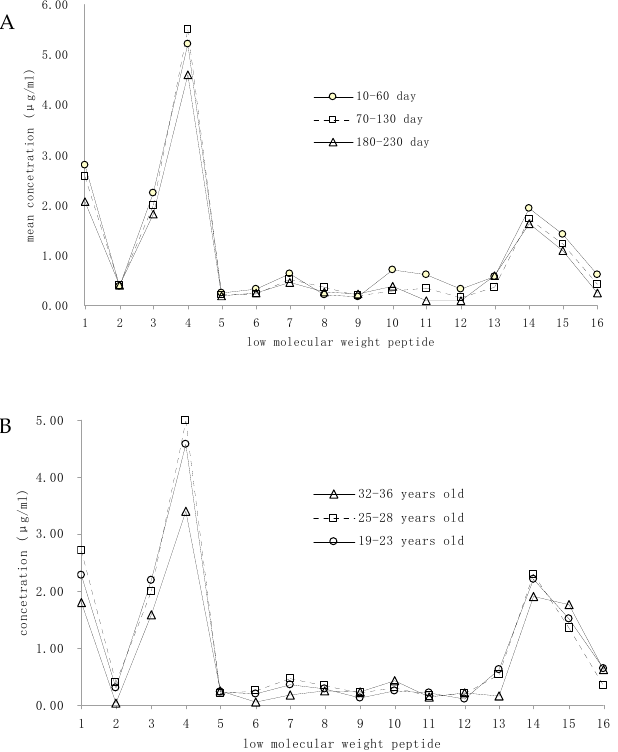
Figure 3. ( A ) The variation of main LMWPs with different lactation times. ( B ) The variation of main LMWPs with different childbearing ages. 1: RETIESLSSSEESITEYK; 2: RE- TIESLSSSEESITEYKQKVEK; 3: RETIESLSSSEESITEYKQKVEKVK; 4: ETIESLSSSEESITEYK; 5: ETIESLSSSEESITEYKQKVEK; 6: SITEYK; 7: TEYK; 8: QPAVVLPVPQPEIMEVPKAKDTVYTKG; 9: VVLPVPQPEIMEVPK; 10: VVLPVPQPEIMEVPKAKDTVYT; 11: LPVPQPEIMEVPK; 12: PQTLA; 13: NPTHQIYPVTQPLAPVHNPISV; 14: TQPLAPVHNPISV; 15: QPLAPVHNPISV; 16: PLAPVHNPISV.